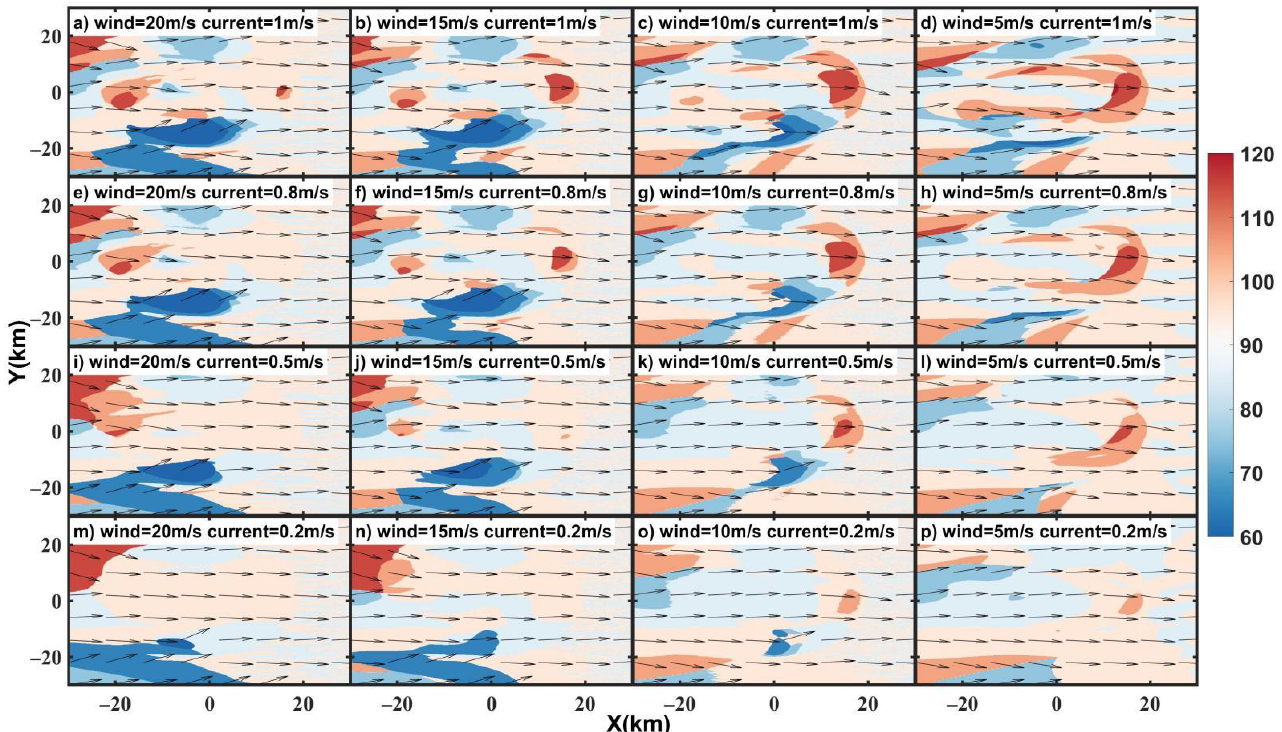
Figure 6. Instantaneous peak wave direction ( θ w ) distribution. The background color represents the peak wave direction values. Arrows are the peak wave direction.